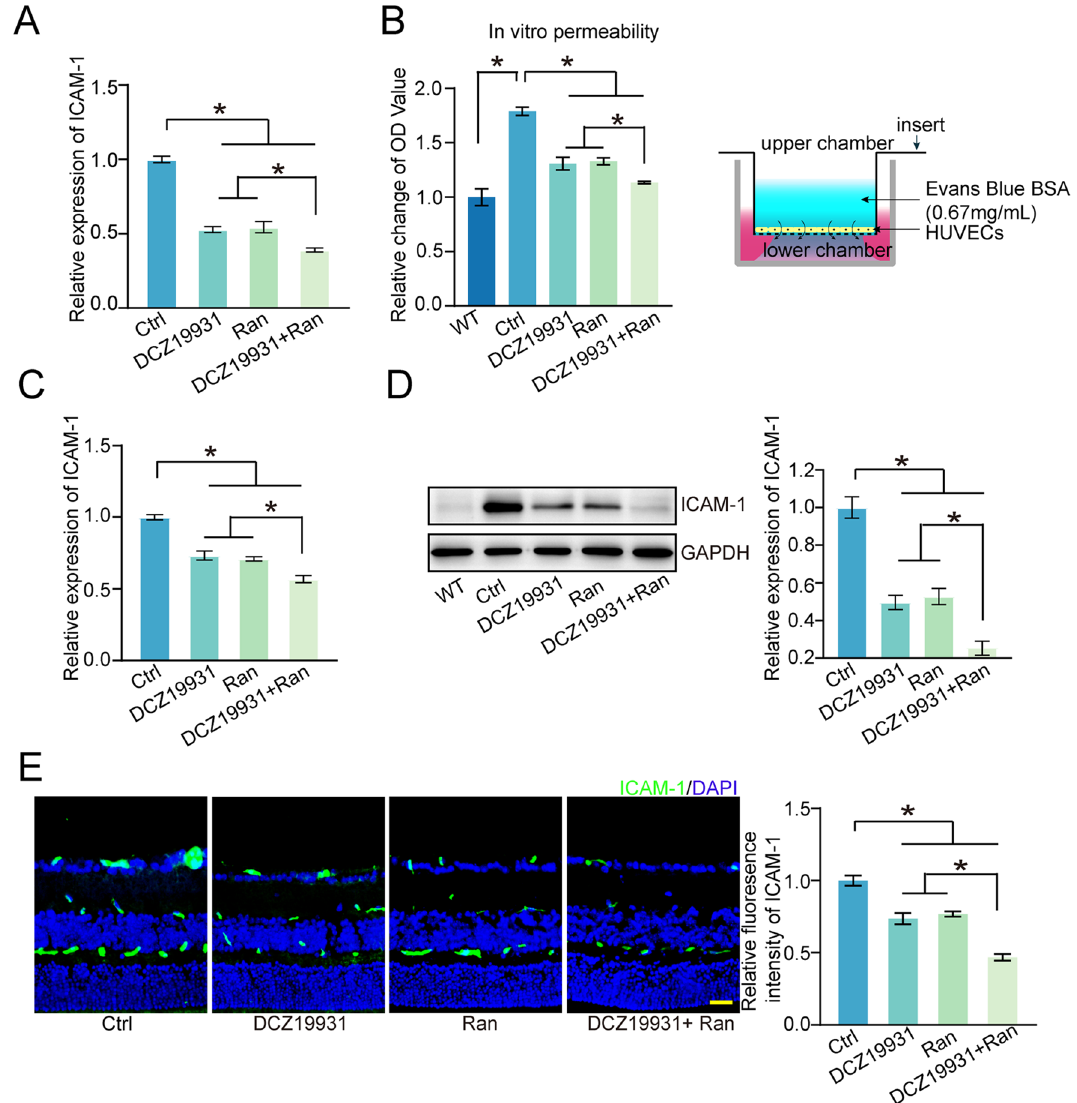
Figure 5. DCZ19931 inhibits vascular permeability via downregulation of ICAM-1 expression. ( A ) HUVECs were cultured with VEGF (Ctrl, 10 ng/mL), VEGF (10 ng/mL) plus DCZ19931 (500 nM), VEGF (10 ng/mL) plus Ranibizumab (250 μg/mL), VEGF (10 ng/mL) plus DCZ19931 (500 nM) and Ranibizumab (250 μg/mL) for 24 h. qRT-PCR assays were performed to detect the expression of ICAM-1 mRNA in HUVECs (n = 4). ( B ) HUVECs were cultured with VEGF (Ctrl, 10 ng/mL), VEGF (10 ng/mL) plus DCZ19931 (500 nM), VEGF (10 ng/mL) plus Ranibizumab (250 μg/mL), VEGF (10 ng/mL) plus DCZ19931 (500 nM) and Ranibizumab (250 μg/mL), or left untreated (WT) for 24 h. WT indicated normal HUVECs without VEGF induction. EB-transwell assays were conducted to detect cell permeability (n = 4). ( C , D ) Laser-induced CNV mice received intravitreal injections of 10% DMSO (2 μL, Ctrl), DCZ19931 (2 μL, 1 μg/μL), Ranibizumab (2 μL, 10 mg/ mL), Ranibizumab (1 μL, 10 mg/mL) plus DCZ19931 (1 μL, 1 μg/μL) after laser injury. WT indicated normal mice without CNV induction. qRT-PCR assays were performed to detect the expression of ICAM-1 mRNA in choroidal tissues at day 7 after treatment ( C , n = 5). Western blots were performed to determine ICAM-1 expression in choroidal tissues. GAPDH was used as the internal control. Representative immunoblots along with the quantitative results were shown ( D , n = 5). ( E ) The pups of OIR mice at P12 received intravitreal injections of 10% DMSO (1 μL, Ctrl), DCZ19931 (1 μL, 1 μg/μL), Ranibizumab (1 μL, 10 mg/mL), 1 μL of Ranibizumab (10 mg/mL) plus DCZ19931 (1 μg/μL) mixture. ICAM-1 immunofluorescence assays were conducted to determine ICAM-1 expression in OIR model. The representative images with the quantitative results were shown (n = 5, scale bar, 50 μm; nuclei, blue; ICAM-1-positive cells, green). Statistical significance was determined by one-way ANOVA followed by Bonferroni post hoc test. * P < 0.05 indicated significant difference between the marked